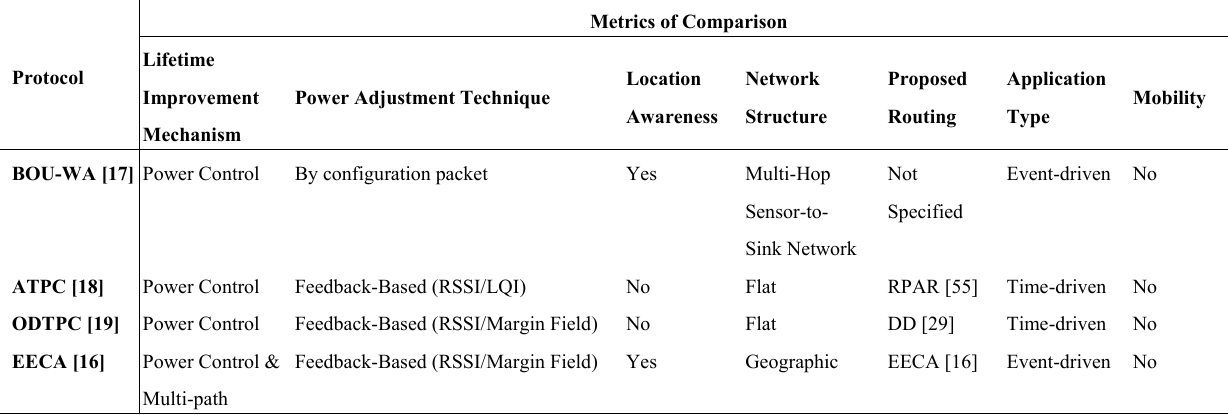
Table 3. Comparison of power control